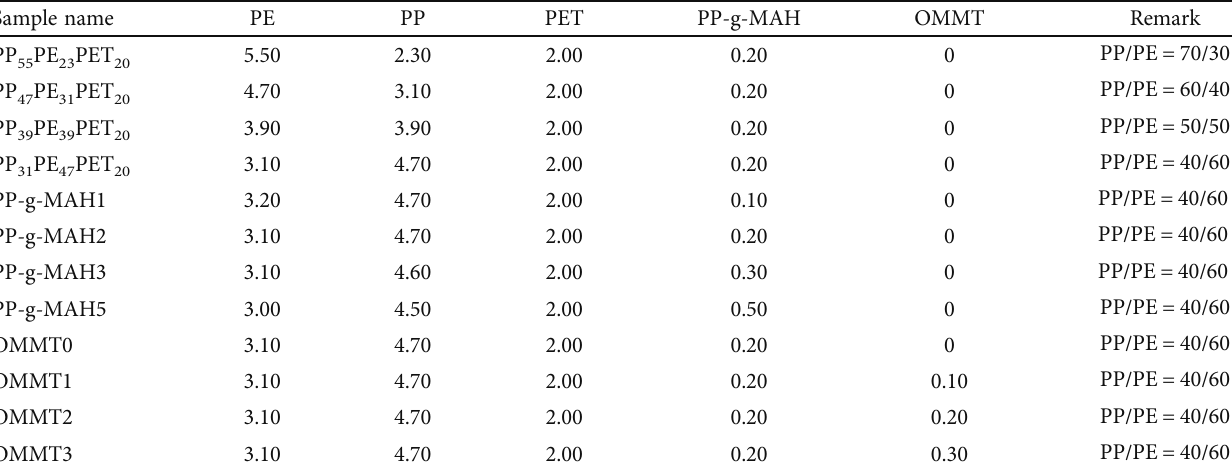
Table 1: Formulation of the tested composites (unit: g).